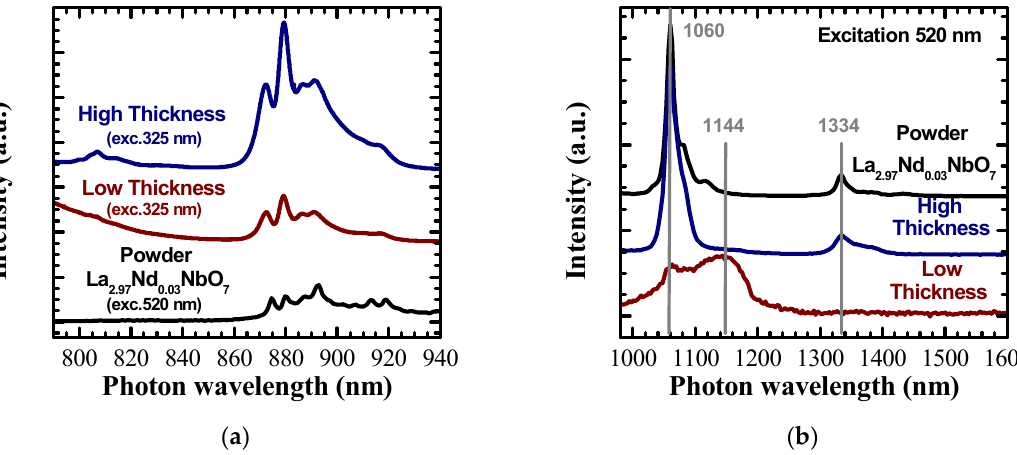
Figure 9. Comparison between the near-IR photoluminescence spectra of Nd-doped lanthanum niobate in both layer thickness sputtering conditions for excitation wavelengths of: ( a ) 325 nm and ( b ) 520 nm. (Figure 8b) The spectrum (excited at 520 nm) of the solid-state reaction pellet sample of La 2.97 Nd 0.03 NbO 7 is included as a reference (black line).